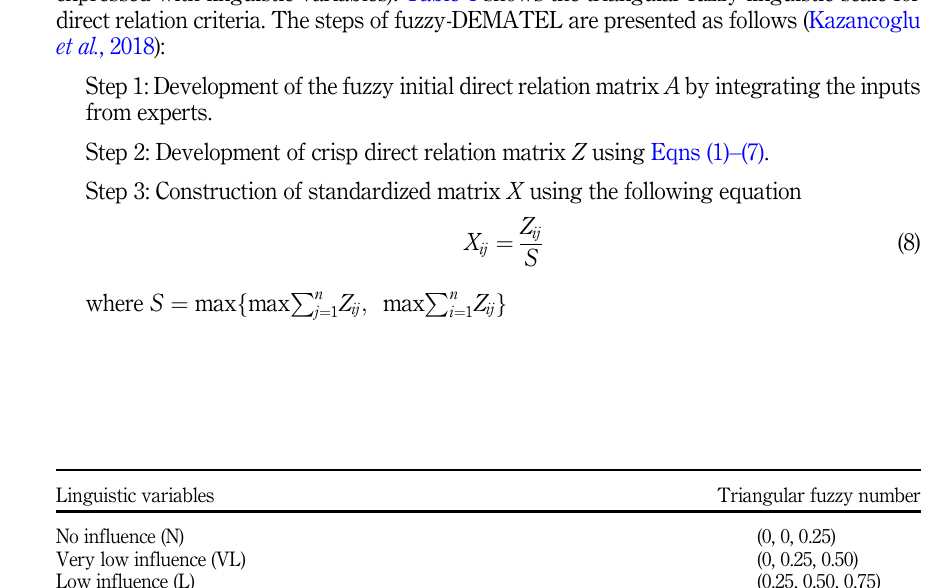
Table 4. The fuzzy linguistic